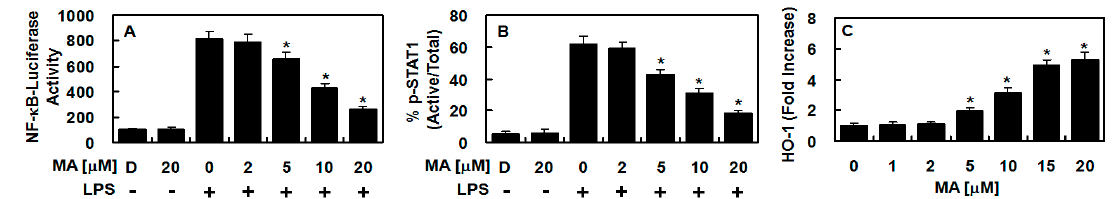
Figure 2. MA suppressed NF- κ B activity and phosphorylation level of STAT-1 and upregulated HO-1 protein levels. After LPS stimulation (1 µ g / mL, 6 h), HUVECs were treated with indicated concentrations of MA for 6 h. ( A ) NF- κ B activity was analyzed in cells that were transfected with NF- κ B luciferase reporter vector. ( B ) LPS-mediated phosphorylation of STAT1 (p-STAT1) was measured with ELISA. ( C ) Heme oxygenase (HO)-1 expression from the extracted proteins were analyzed with ELISA. The results represent the mean value with SD from three independent experiments conducted in triplicates on three di ff erent days. D denotes 0.2% DMSO treatment, which was used as the vehicle control. * p < 0.05 versus LPS.